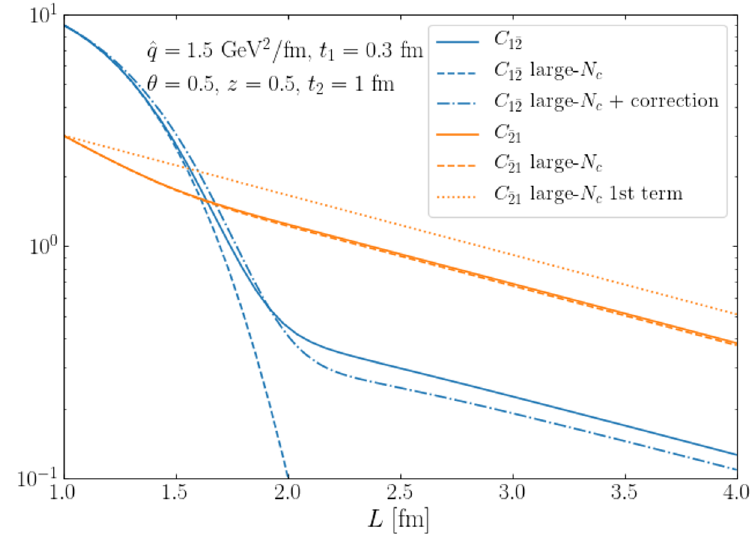
† ] tr[ V ] i (blue, solid and blue, ¯2 V ¯1 2 † ( t ) = h tr[ V ] i (orange, solid and orange, dashed lines, V ¯2 V † ¯21 1 V ¯1 2 approximation of C c